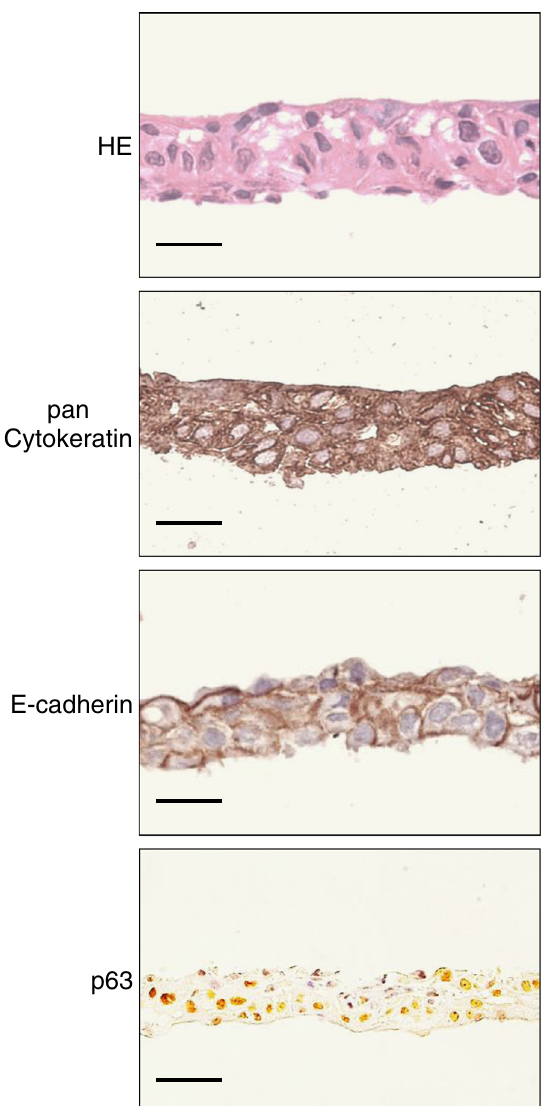
Fig. 2 Histological and immunohistochemical analyses of nasal mucosal epithelial cell sheets. Nasal mucosal epithelial sheets were subjected to paraf fi n-embedded sectioning and stained with HE ( fi rst row), anti-pan cytokeratin (second row), anti-E-cadherin (third row) and anti-p63 (fourth row). The HE-stained specimens showed that fabricated cell sheets consisted multi-layered mucosal epithelial cells. All epithelial cell layers of the fabricated cell sheets expressed pan-cytokeratin. E-cadherin was con fi rmed to be expressed between the epithelial cells in the cell sheets. The epithelial cells in the cell sheets also expressed p63. Bars indicate 25